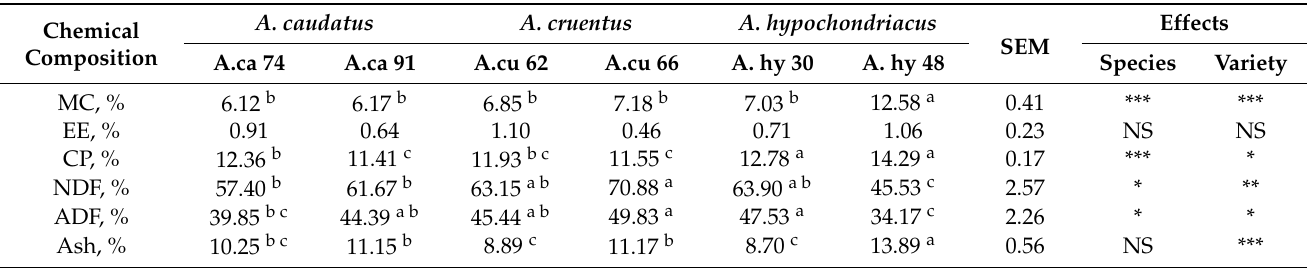
Table 1. Chemical compositions of different amaranth